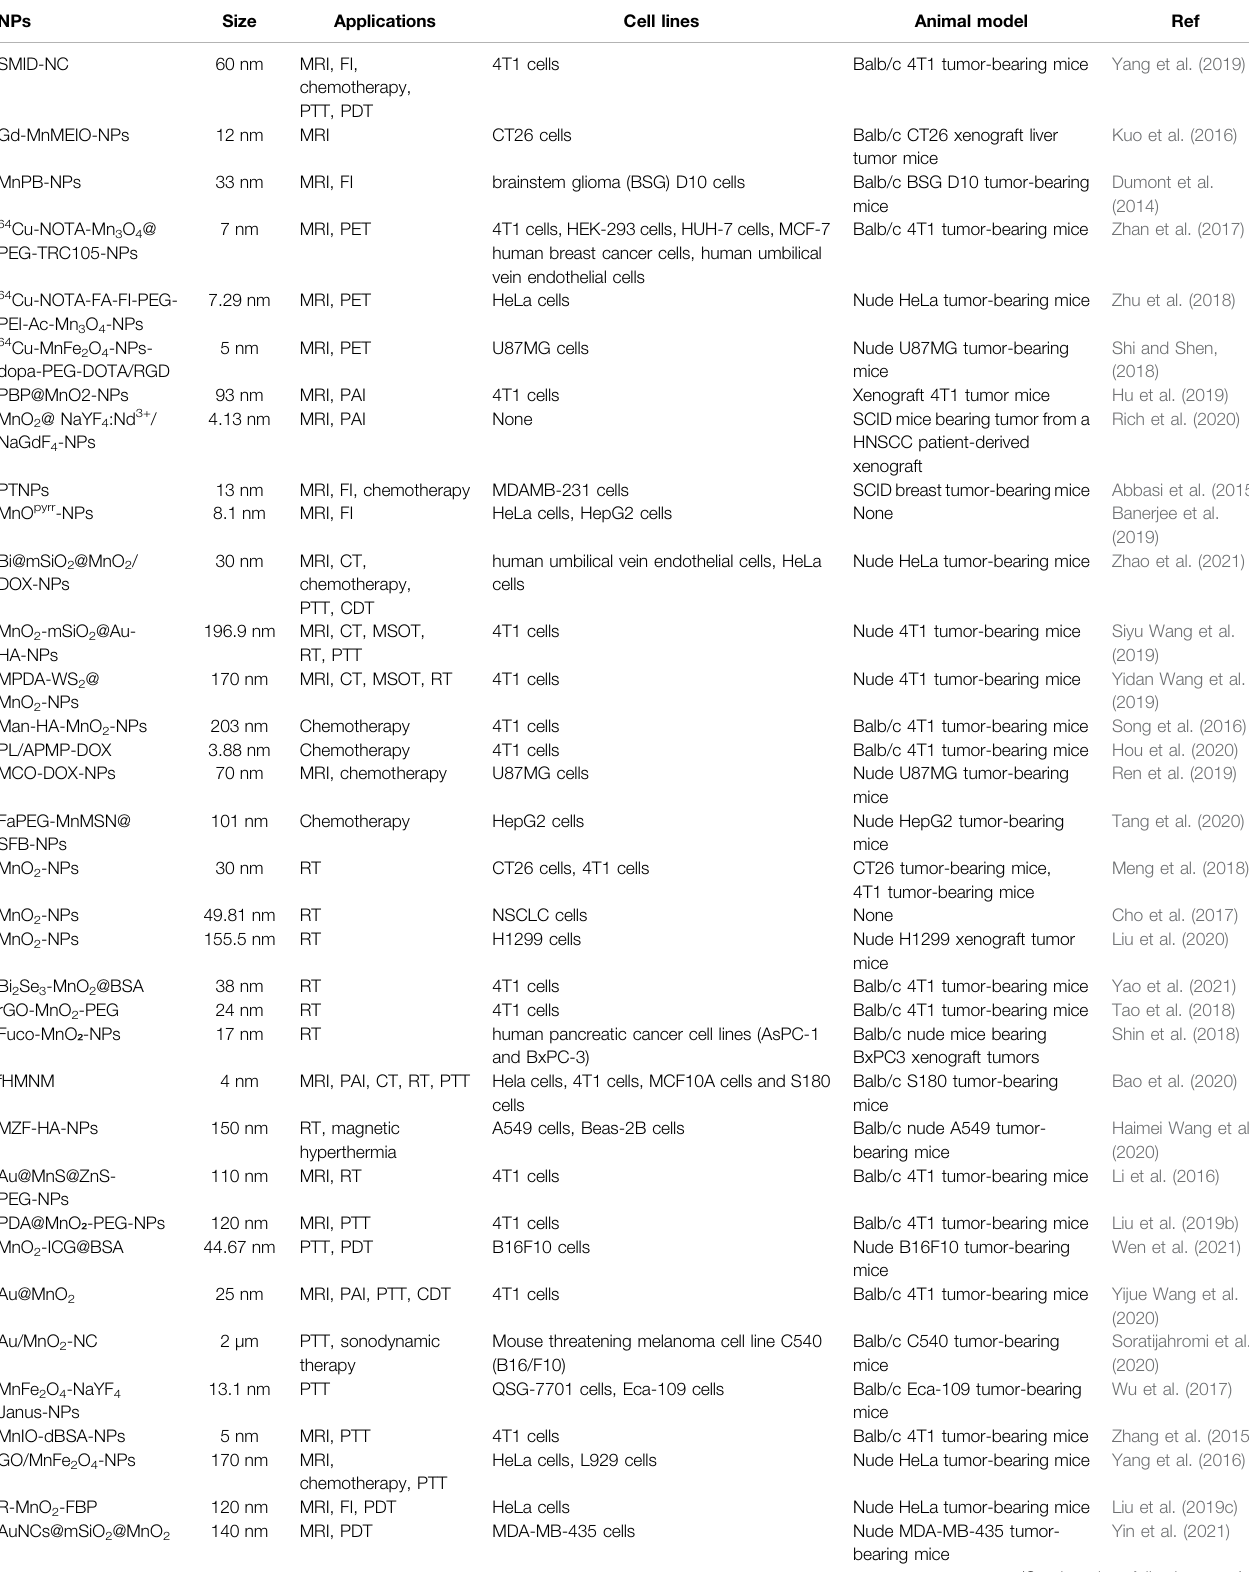
TABLE 1 | Summary of the application of Mn-NPs in cancer diagnosis and